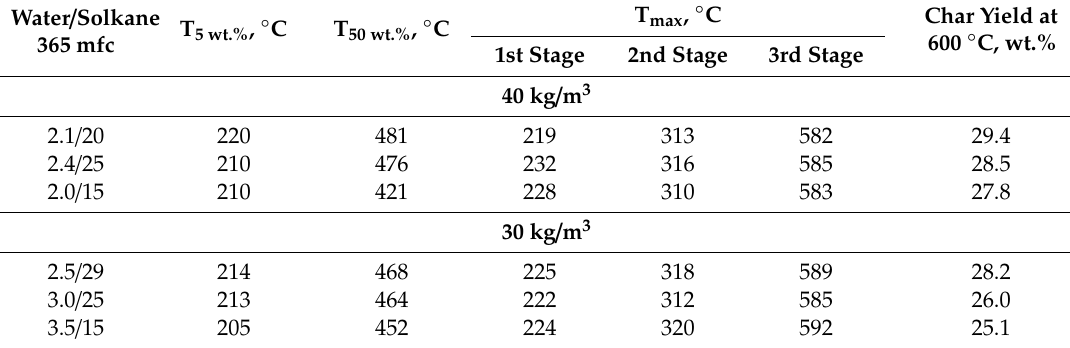
Table 7. Thermal degradation parameters of the stable polyurethane foams.